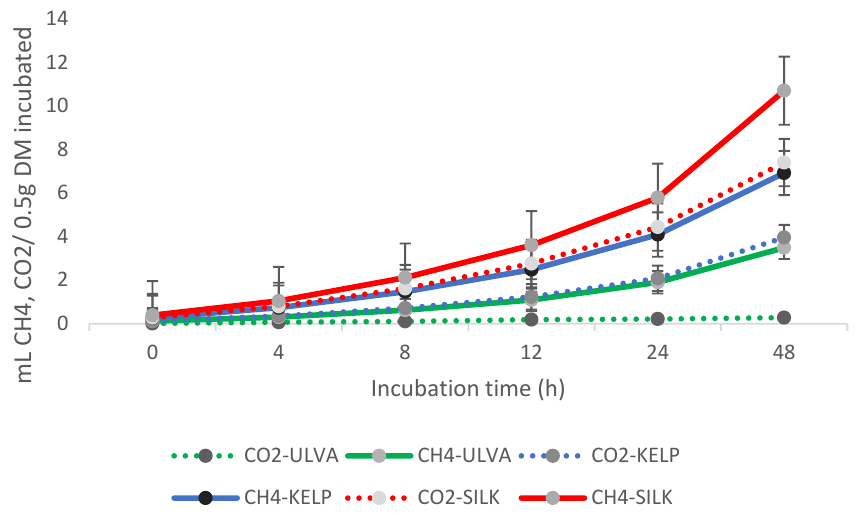
Figure 3. Effects of Kelp, Ulva, and Silk algae on ruminal CO 2 and CH 4 in vitro production (mL/0.5 g incubated DM).